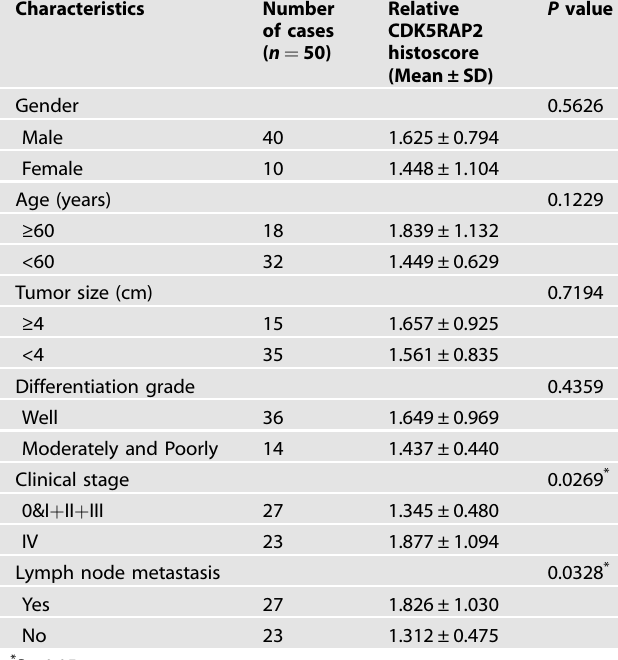
Table 1. Clinicopathologic features of OSCC